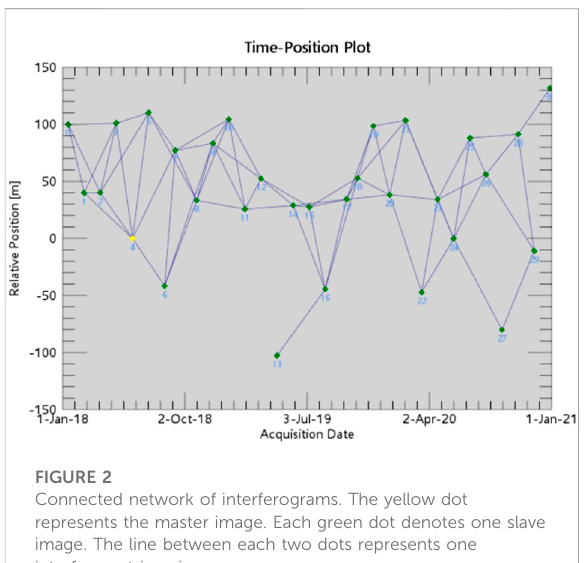
FIGURE 2 Connected network of interferograms. The yellow dot represents the master image. Each green dot denotes one slave image. The line between each two dots represents one interferometric pair.